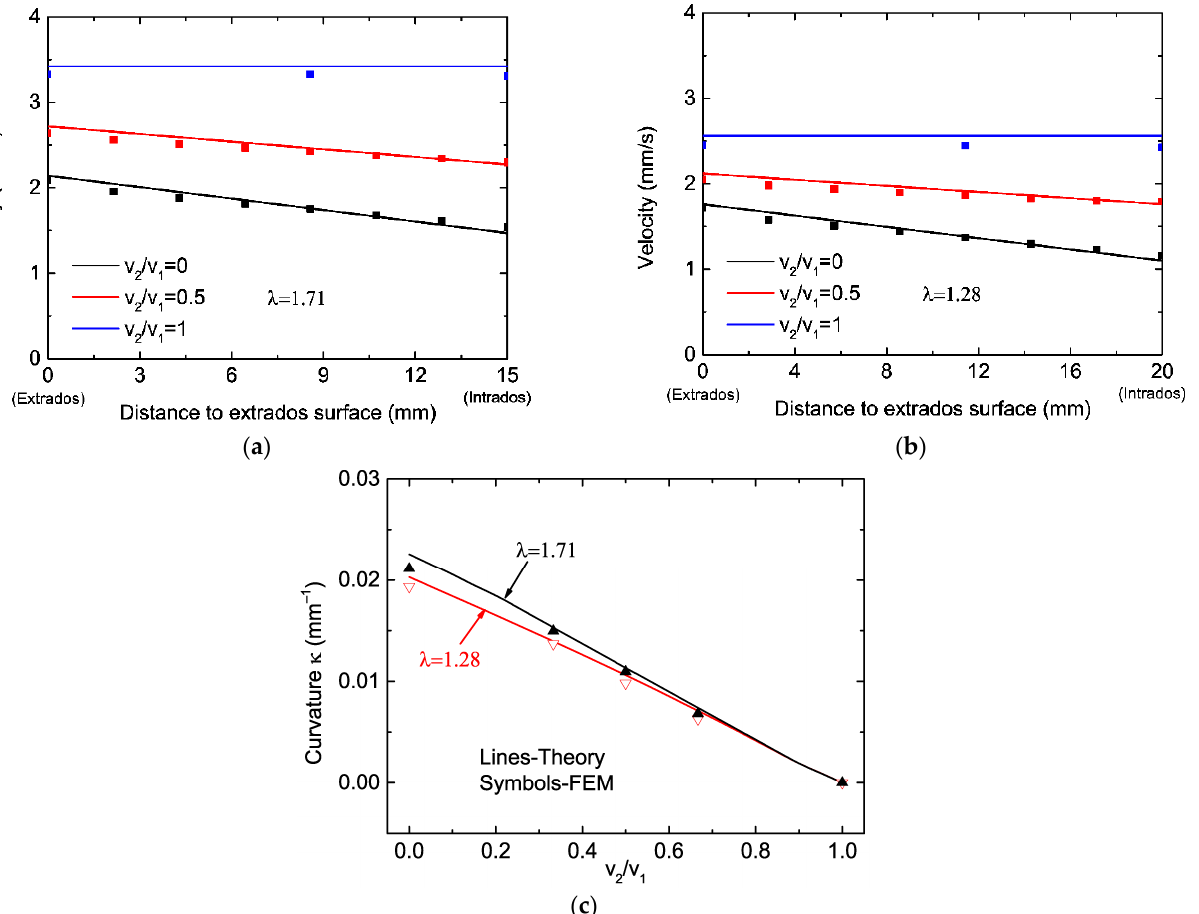
Figure 6. Material flow velocity across the die orifice and extrudate curvature obtained from theory (lines) at different n values, and comparison of those extracted from FEM (symbols): ( a ) velocity, λ = 1.71, ( b ) velocity, λ = 1.28 and ( c ) curvature.